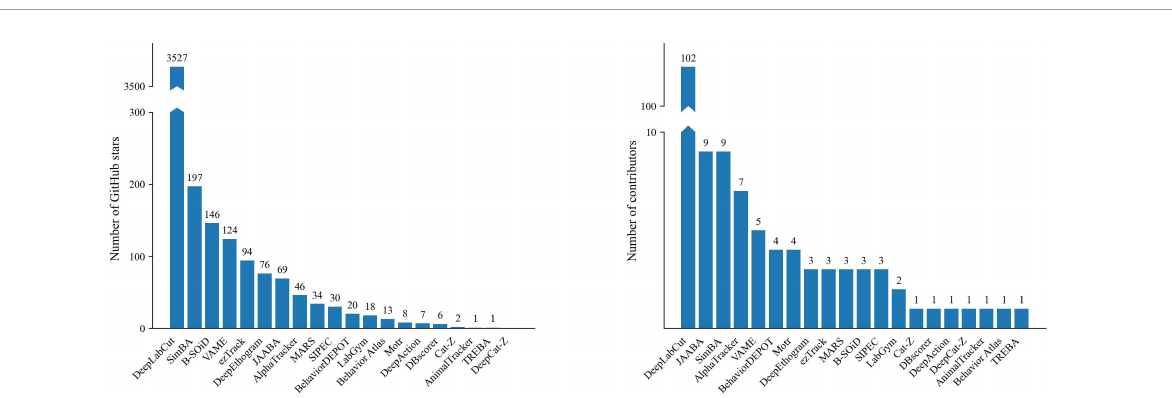
FIGURE2 Popularity of open-source repositories as assessed by the number of GitHub stars (left panel) and contributors (right panel) as of March